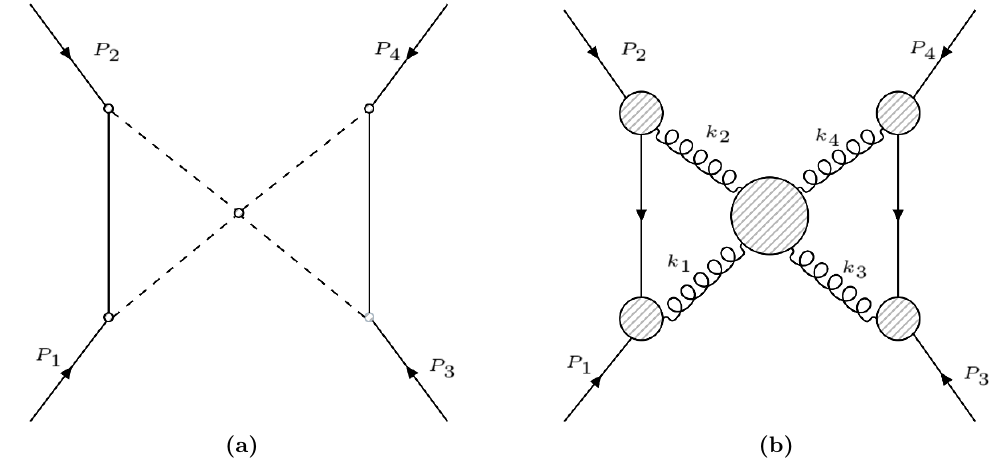
Figure 6. The product triangle scalar diagram and its gravitational counterpart. The gravity diagram also contains double boxes that emerge when one of the propagators is cut in the 4-graviton